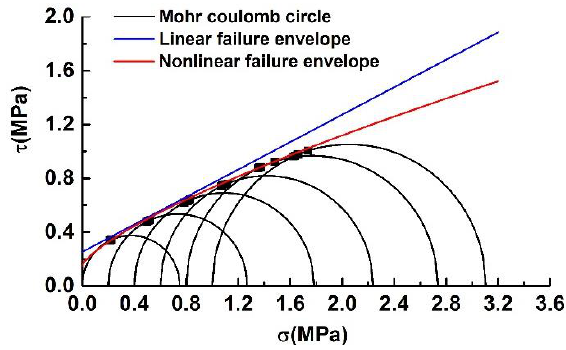
 −  −  − space at 60 °C. space at 60 °C. space at 60 °C.